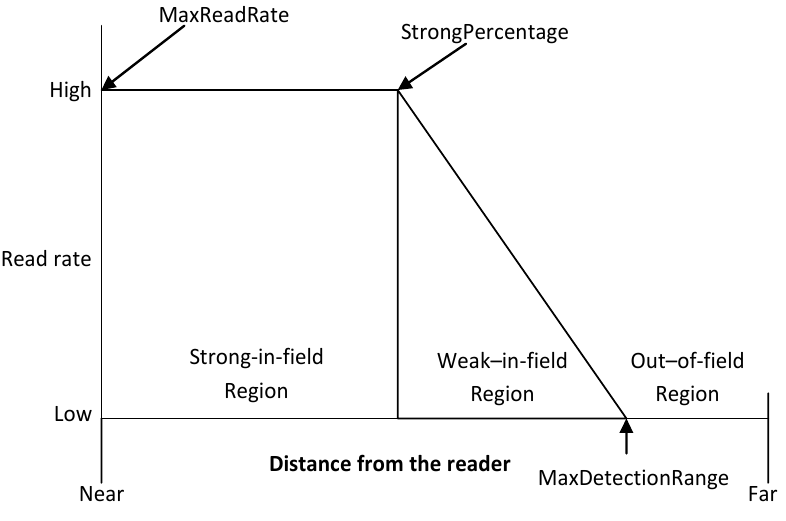
Figure 5. P assive RFID tag-reader detection